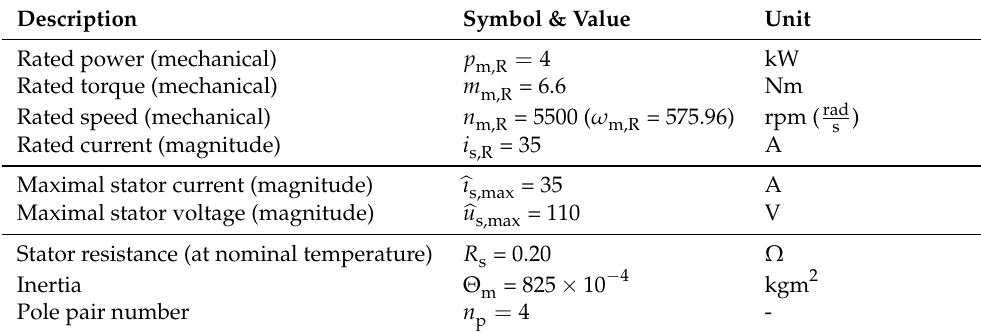
Table 3. Rated machine parameters of the considered 4kW IPMSM.